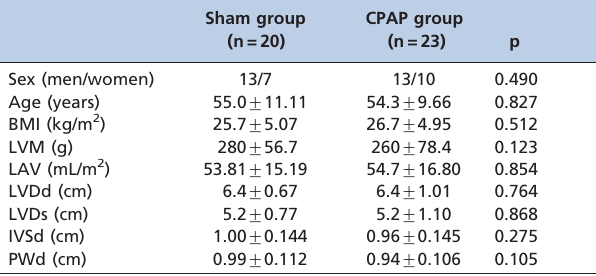
Table 1 - Baseline anthropometric and morphometric characteristics of the patients.